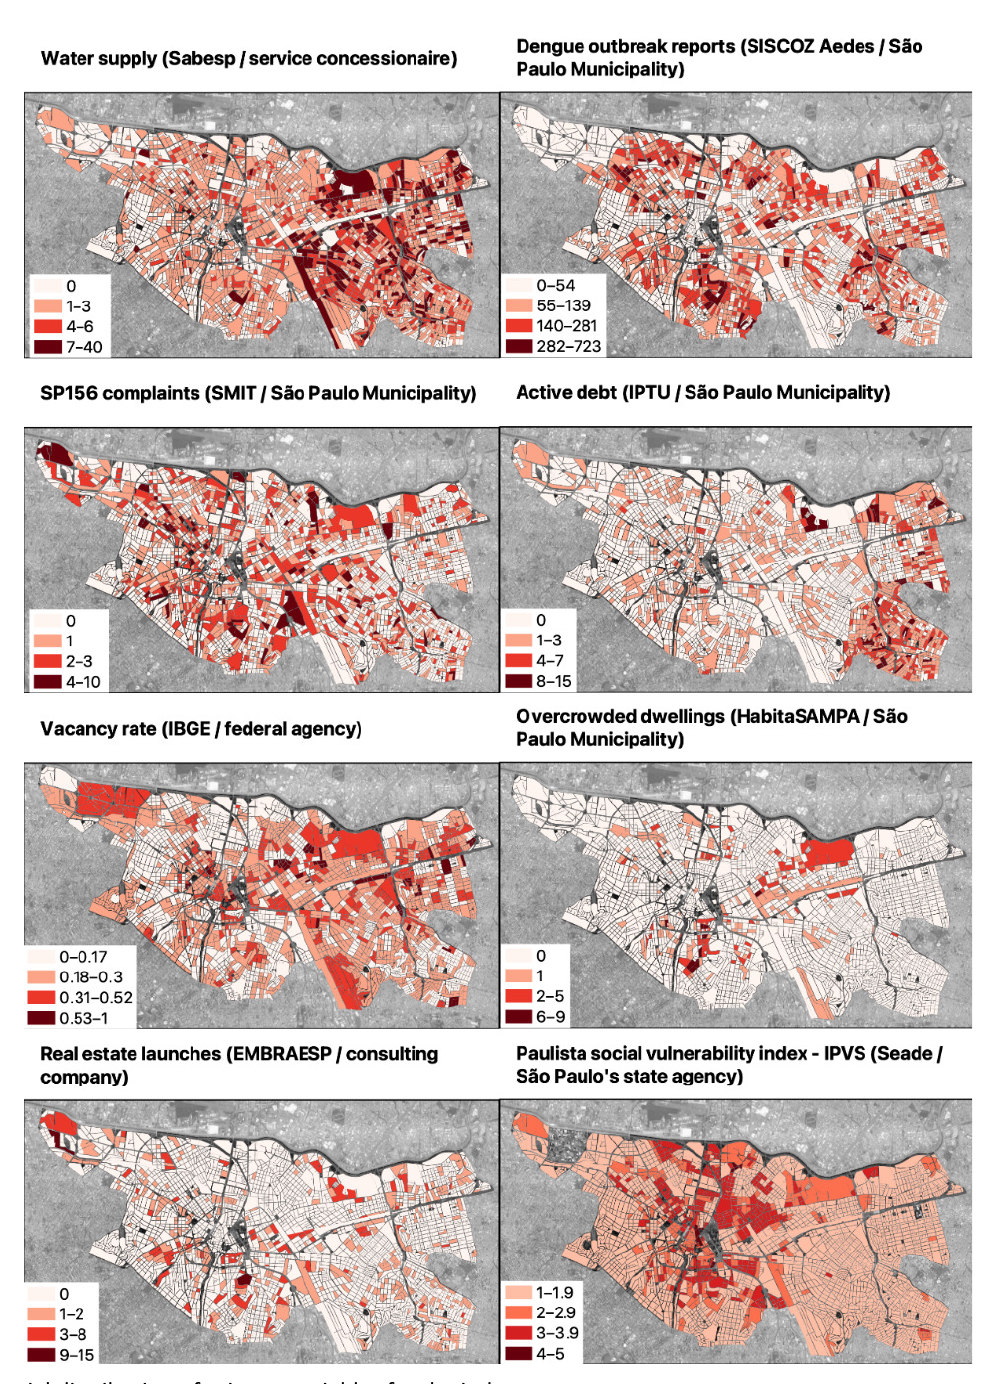
Figure 3. Spatial distribution of primary variables for the index. irrelevant) to four (the most relevant), the questionnaire aimed at ranking from least to most relevant the weight of each variable within the index. The weight, therefore, was defined by the mean value of the 22 responses to each variable. The final weights are shown in Table